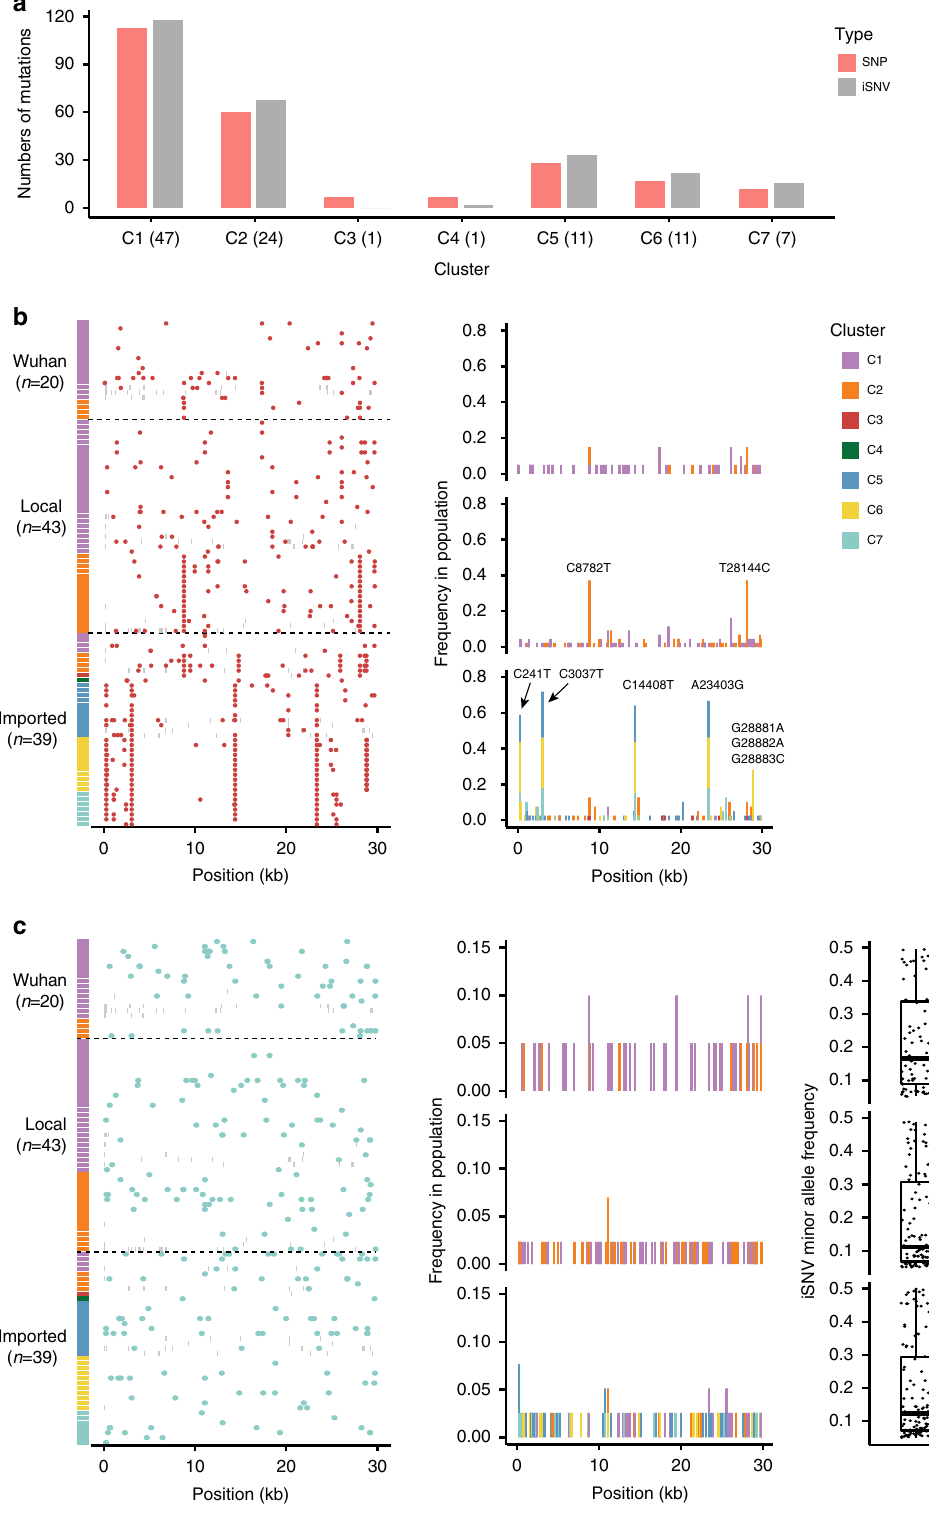
Fig. 3 The distribution of SNPs and iSNVs in the viral genomes sequenced in this study. a The numbers of SNPs and iSNVs in each cluster. The number of genomes in each cluster are displayed in the brackets. b The distribution (left) and frequency (right) of SNPs identi fi ed in the 102 genomes of the three groups and seven clusters. The red dots represent the positions of SNPs. The histogram shows the frequencies of the SNPs in each cluster. c The distribution (left), frequency (middle), and minor allele frequency (right) of iSNVs identi fi ed in the 102 genomes of the three groups and seven clusters. The green dots represent the positions of iSNVs. The histograms show the frequencies of the iSNVs in the enrolled population. The boxplots and scatter plots show the minor allele frequency of iSNVs. Boxplots indicate median (middle line), the fi rst and third quartiles (box), the fi rst quartile minus 1.5-fold the interquartile range, and the third quartile plus 1.5-fold the interquartile range. Source data are provided as a Source Data fi